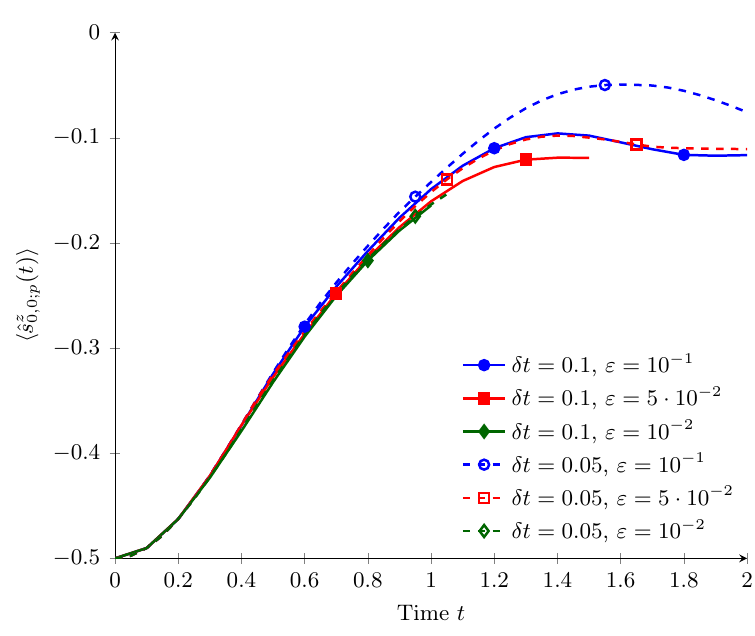
( t ) 〉 at h = 4 for the calculations also shown in Figure 2: Expectation value of 〈 ˆ s z 0,0; p Fig. 1. The selected setting δ t = 0.1, (cid:34) = 0.05 is very close to the higher-precision cal- culations with (cid:34) = 10 − 2 , though those exhaust the available bond dimension